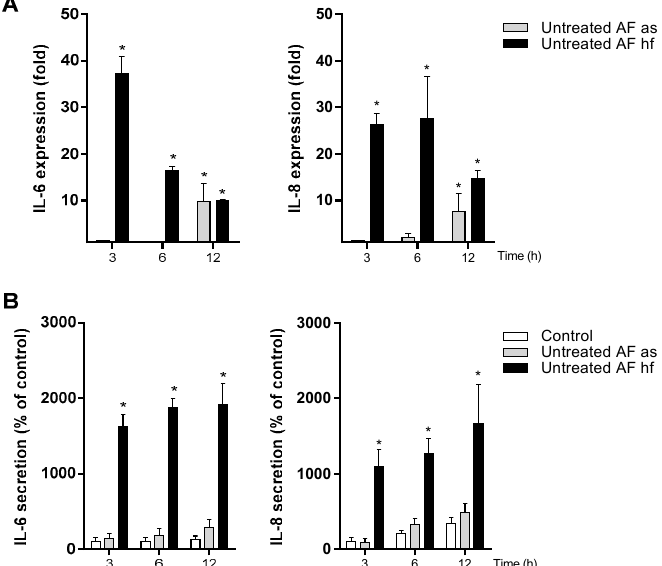
Figure 7. Time-dependent expression and release of IL-6 and IL-8 after exposure to untreated spores and hyphal fragments from A. fumigatus . Cells were exposed to untreated aerosolized spores (as) or hyphal fragments (hf) of A. fumigatus (67 µ g dry weight/mL) for three different time points. Medium blanks were included as control. ( A ) Expression of IL-6 and IL-8 were measured by real-time RT-PCR. ( B ) Release of IL-6 and IL-8 were measured with ELISA. Bars represent mean ± SEM of <4 independent experiments. Statistical analyses were performed by two-way ANOVA with Dunnett’s post-tests on log transformed or 2-step normalized data respectively. Significant difference compared to the control denoted by * p < 0.05.